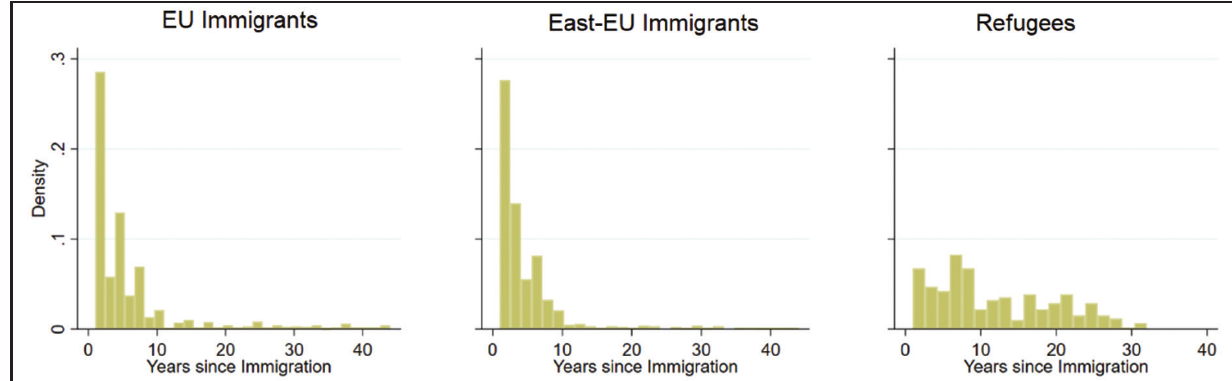
Figure W12 Distributions of years since immigration at the entry year into the subsidized sector, with entry defined as going from 0 to 6 months of wage income.